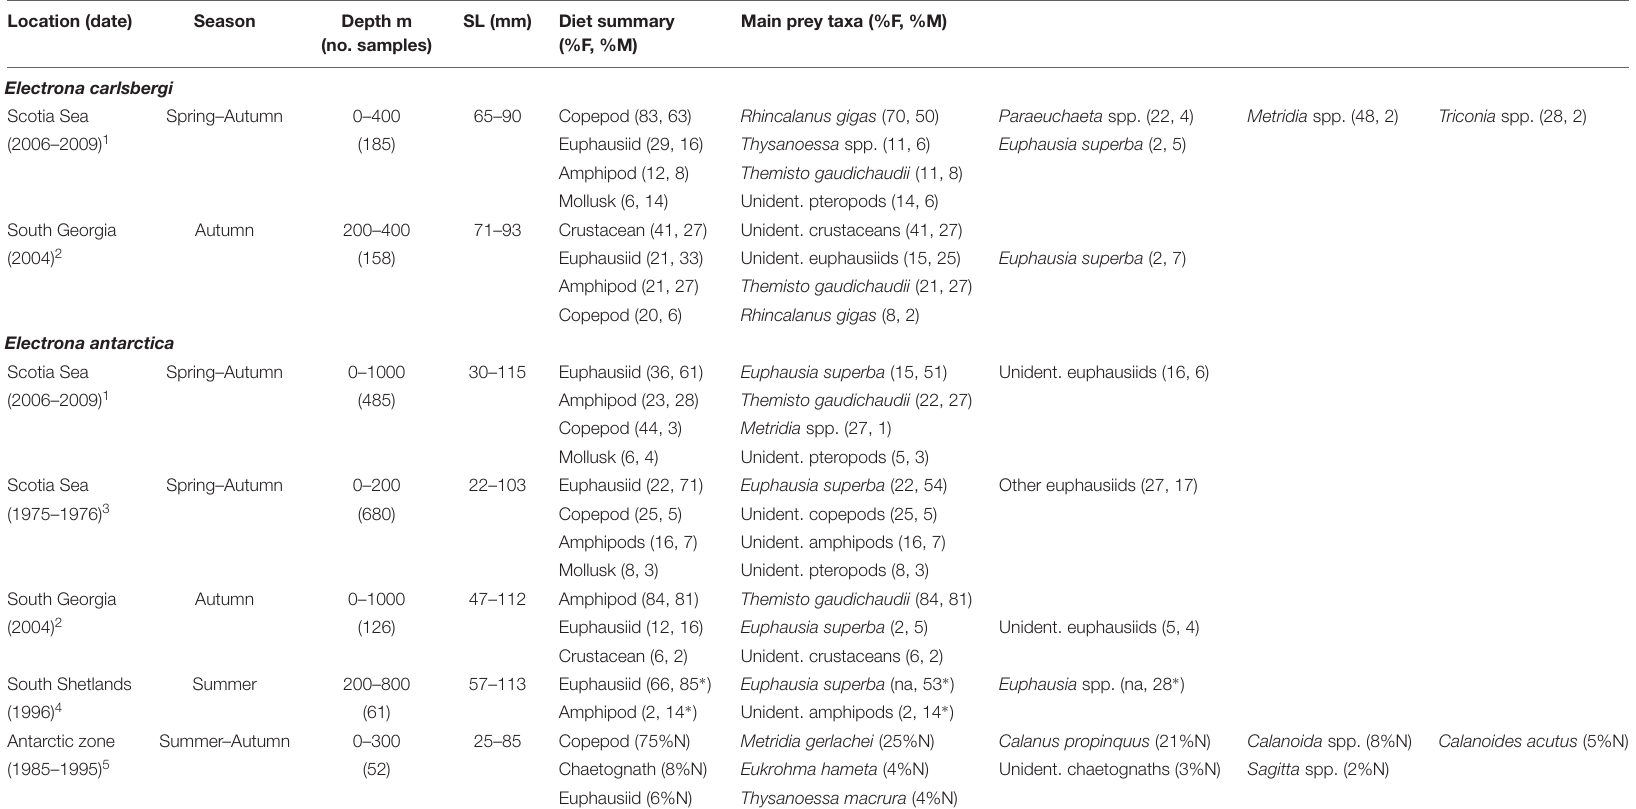
TABLE 2 | Diet of Electrona carlsbergi and Electrona antartica in the Scotia Sea expressed by percentage frequency of occurrence (%F) and percentage mass